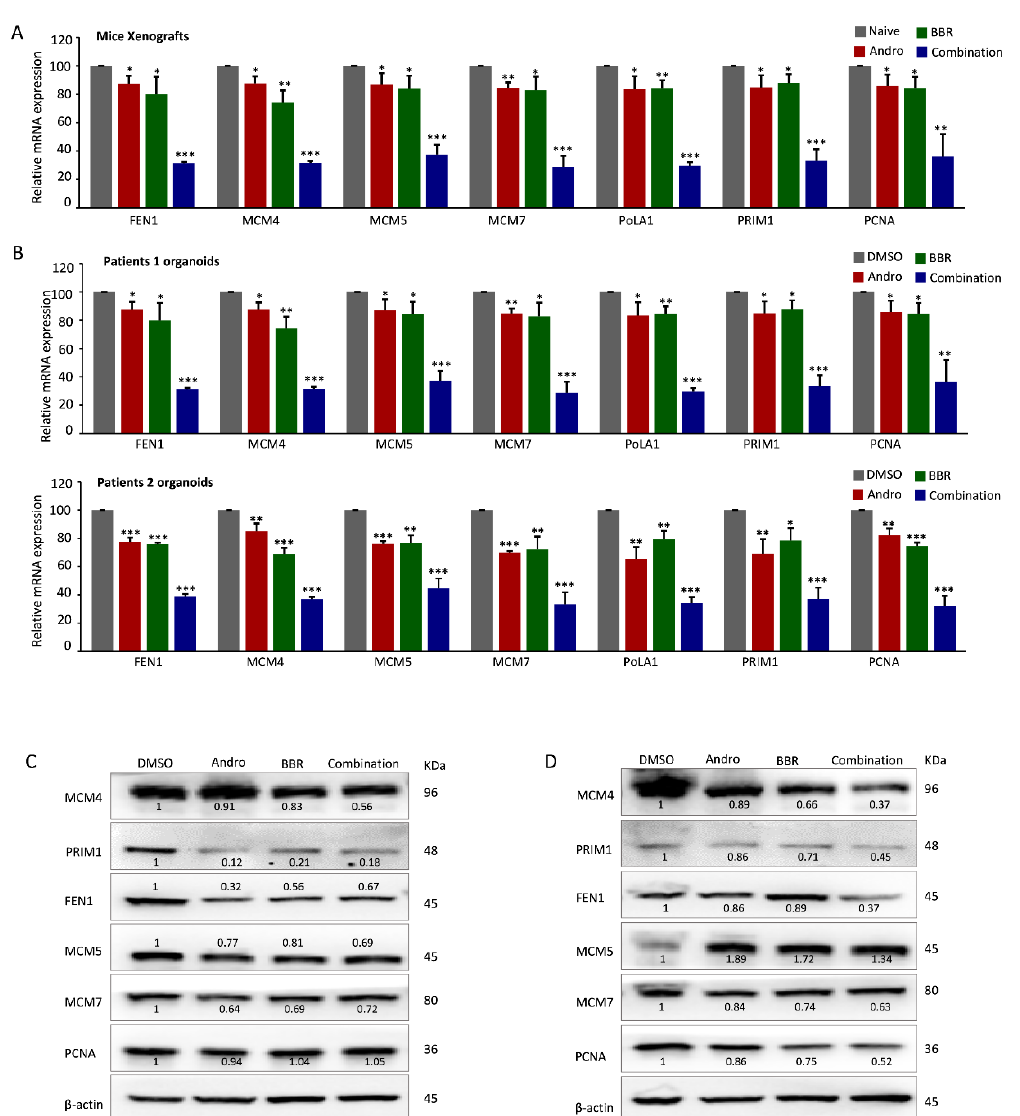
Figure 5. Andrographis and berberine mutually enhance the inhibition of DNA replication in mouse xenografts and patient-derived tumor organoids. ( A ) A bar graph showing the relative mRNA ex- pression of FEN1, MCM7, PRIM1, MCM5, POLA1, MCM4, and PCNA in dissected tumor xeno- grafts after being treated with berberine and/or Andrographis; ( B ) A bar graph showing the relative mRNA expression of DNA-replication-related genes in two strains of patient-derived tumor organ- oids; ( C , D ) The protein immunoblot analysis of DNA-replication-related proteins in RKO cells and dissected tumor xenografts treated with berberine and/or Andrographis. Statistical Significance: * p < 0.05, ** p < 0.01, *** p < 0.001. BBR, berberine; Andro, Andrographis.